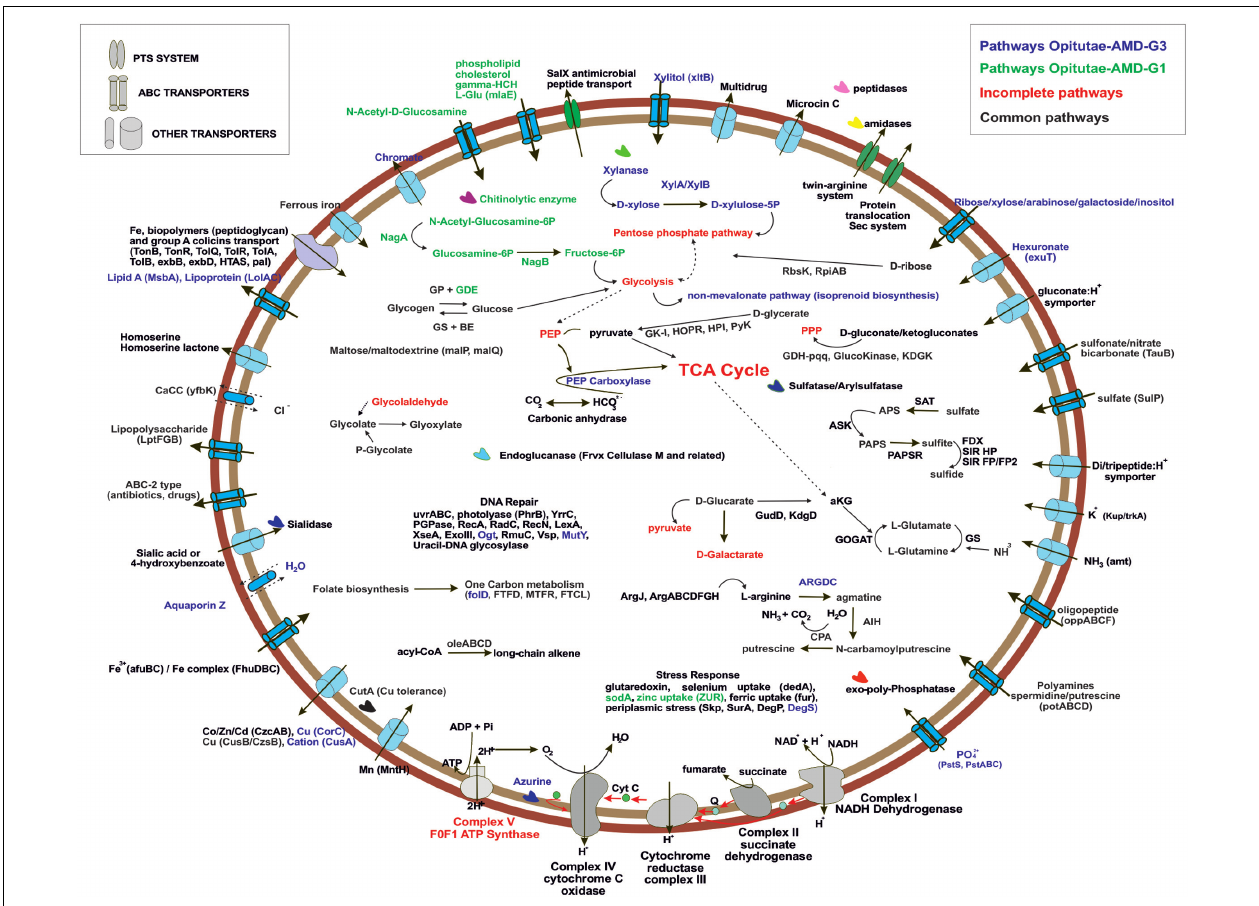
FIGURE 4 | Metabolic overview of Opitutae-AMD-G1 and Opitutae-AMD-G3 Verrucomicrobia genomes. Pathways are color coded. Common pathways are colored in black; incomplete pathways are red colored; specific pathways to Opitutae-AMD-G1 are green; and specific pathways to Opitutae-AMD-G3 are dark